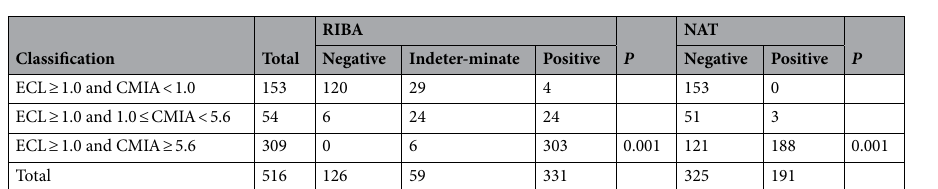
Table 1. Predicting the presence of anti-HCV and HCV-RNA using two serological assays. ECL electrochemiluminescence, CMIA chemiluminescent particle immunoassay, RIBA recombinant immunccoblot assay, NAT nucleic acid amplification